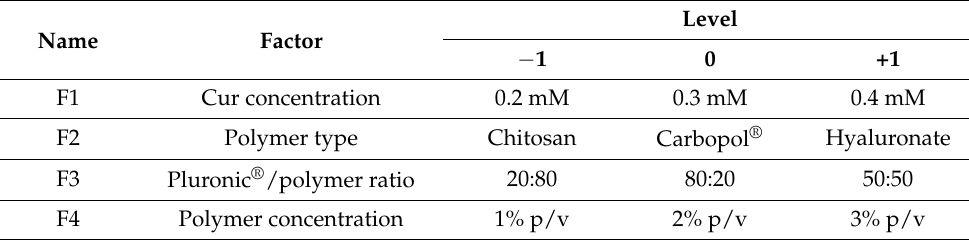
Table 4. Factors (F1, F2, F3 and F4) and their levels selected for the screening study. Experiments were realized by using a Taguchi L9 array. ( − 1): low level; (0): middle level; (+1): high